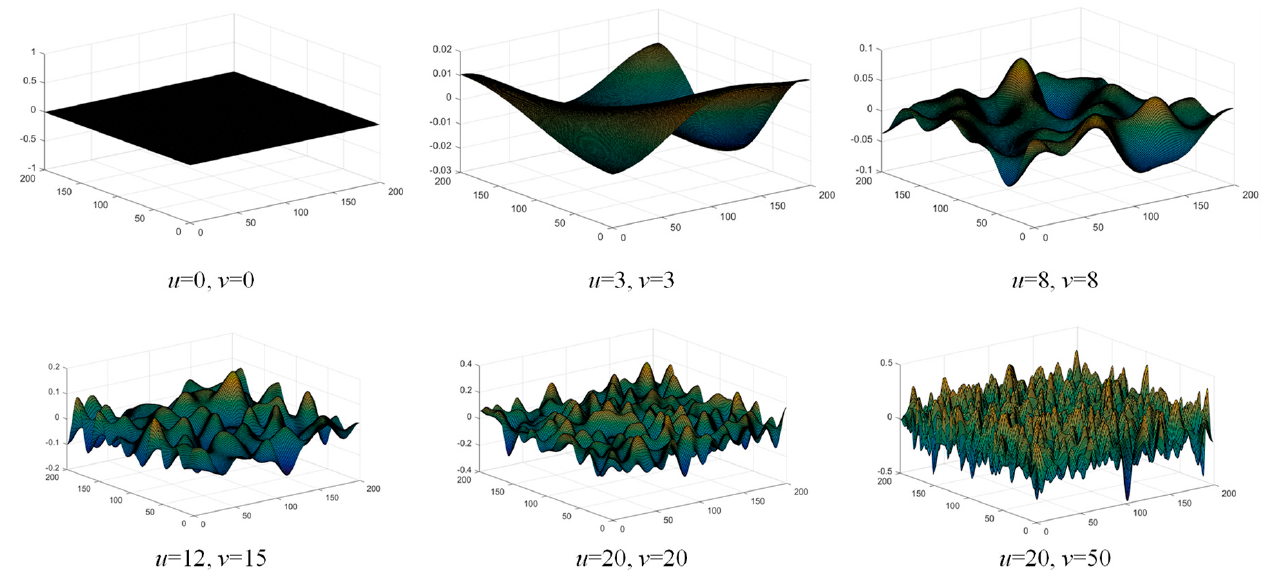
Figure 3. Base shapes of different complexity.